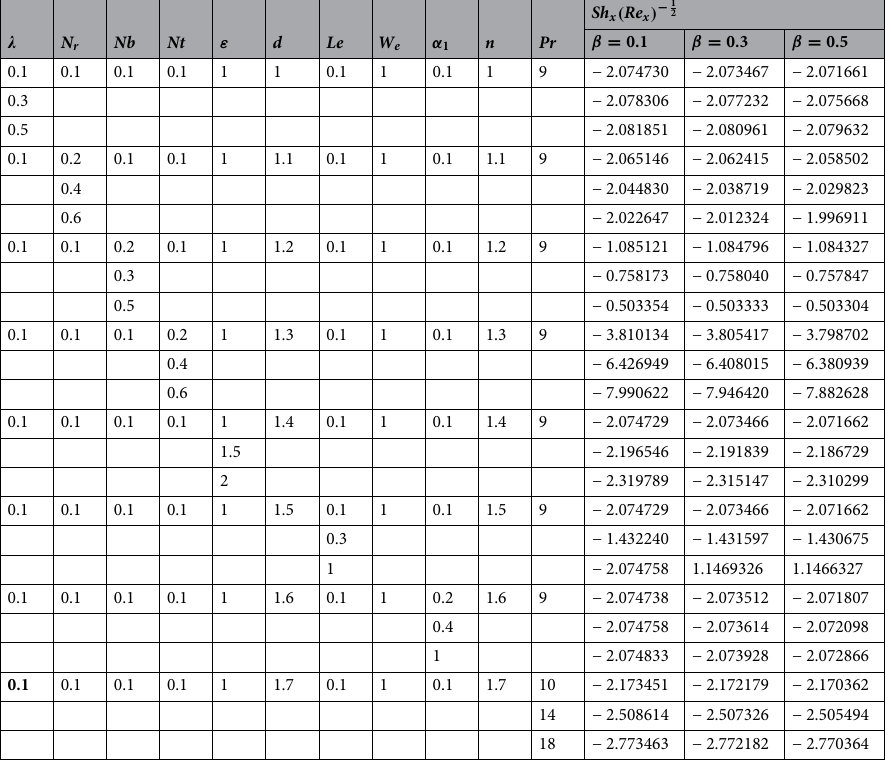
1 2 for distinct amounts of parameters.